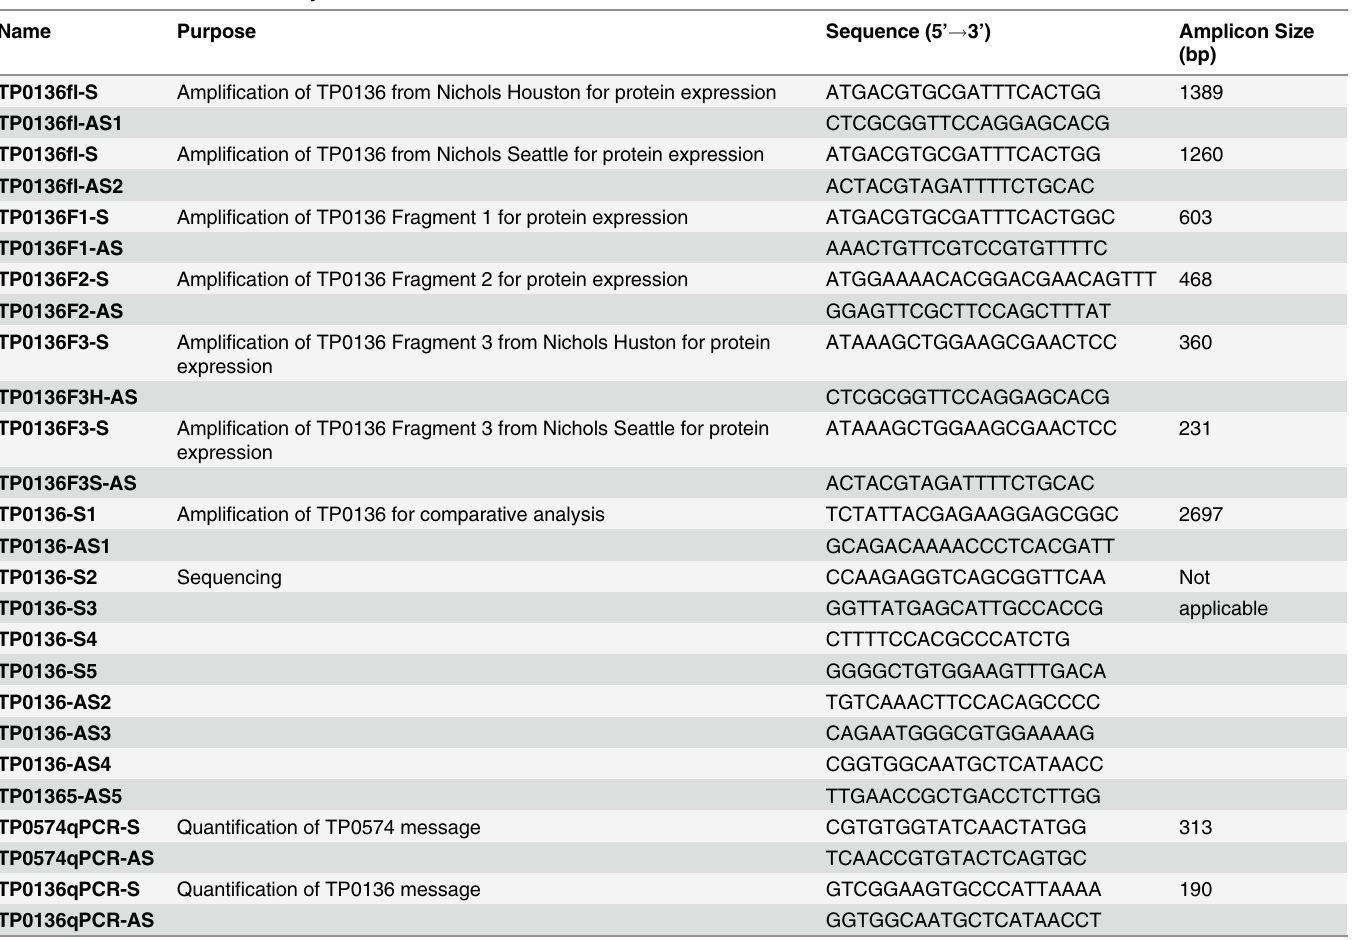
Table 2. Primers used in this